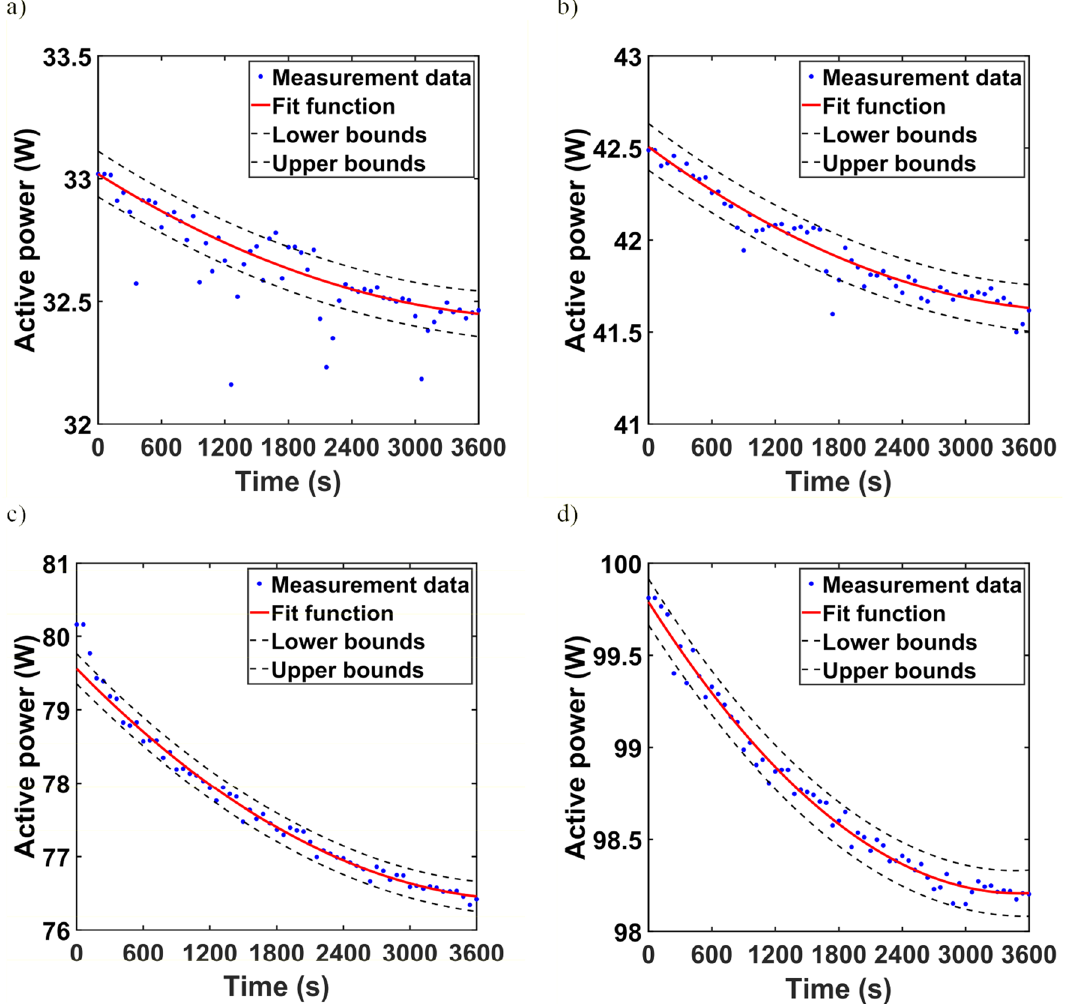
Figure 8. Active power of ( a ) L1 lumianire, ( b ) L2 luminaire, ( c ) L3 luminaire, ( d ) L4 luminaire.